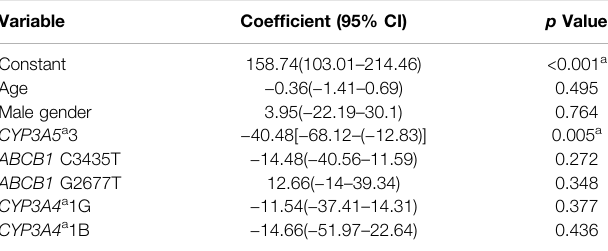
TABLE 5 | Linear regression analysis to fi nd independent predictors of 6th day tacrolimus C 0 /D